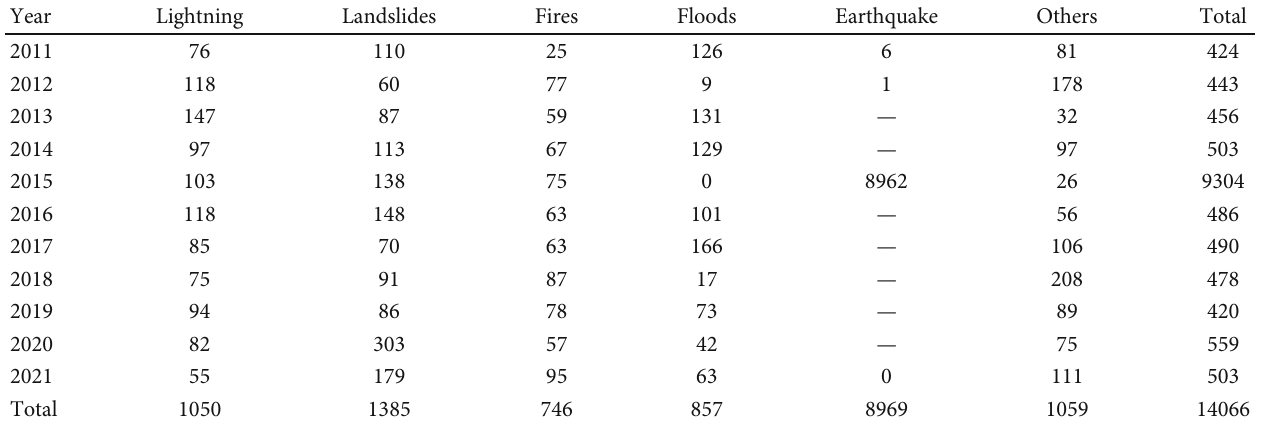
Table 1: Death of people due to natural disasters in Himalayan regions.